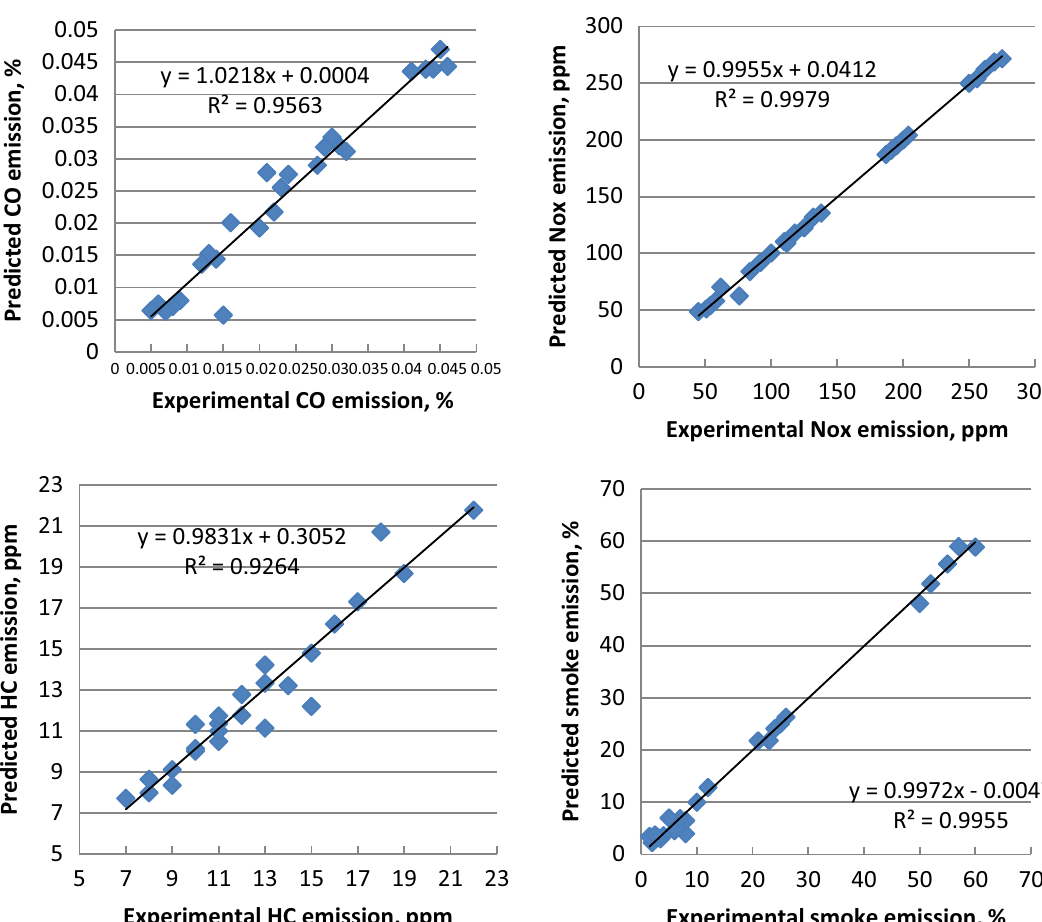
Figure 15. Correlation between ANN model and experimental values of CO, NO x , HC and smoke